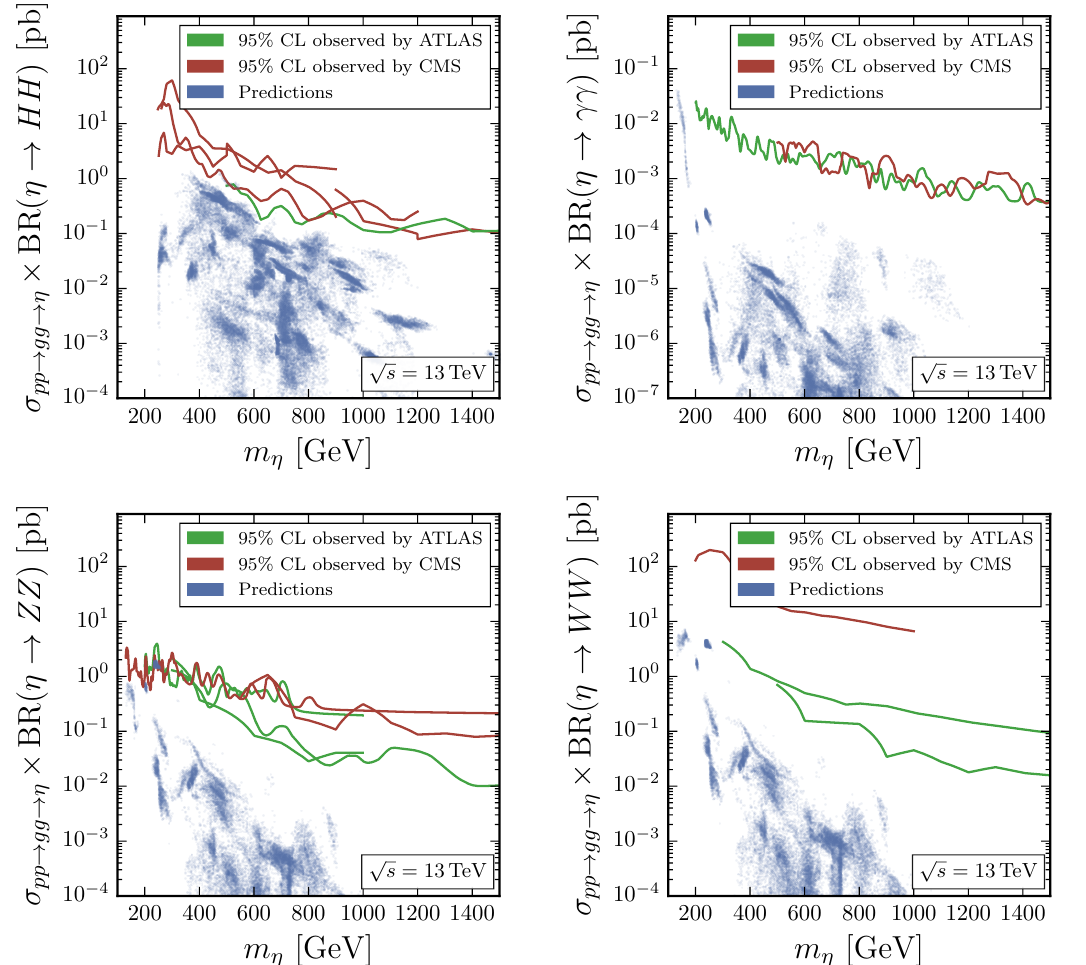
Figure 5 . Experimental bounds from ATLAS and CMS and predictions from viable parameters points of the (cid:17) production cross section via gluon fusion times the branching ratio into hh (top-left), (cid:13)(cid:13) (top-right), ZZ (bottom-left) and WW (bottom-right). The analyses shown in the plots are listed in table